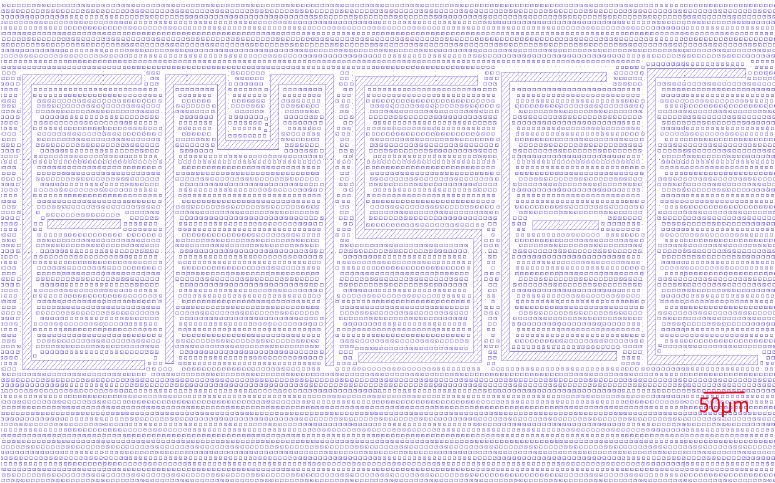
Figure 6. Design of the back end of line of the ASIC , the width of the lines of the writing is 10 µ m.